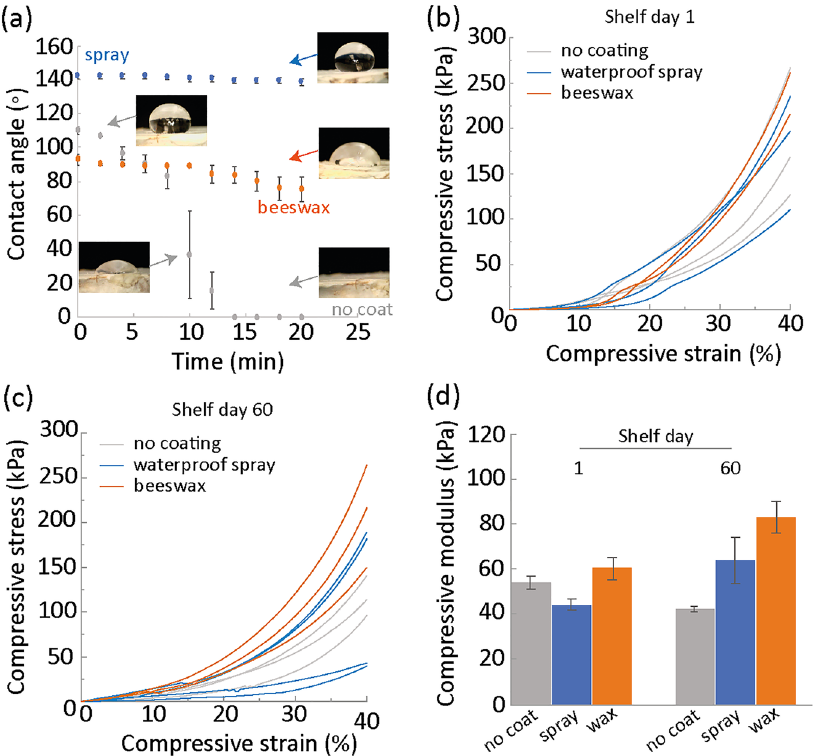
Figure 4. Indoors durability for MBC with no coating (grey), waterproof spray coating (blue) and beeswax coating (orange). ( a ) Contact angle as a function of time after a drop of water was deposited at the surface of the samples. The images show the morphology of the drop at several time points. ( b ) Stress–strain curves obtained under compression for the MBC grown for 28 days, dried, and coated or non-coated. ( c ) Stress–strain curves obtained under compression for the MBC after 60 days indoors shelf storage. ( d ) Elastic modulus of the samples after 1 and 60 days indoors for the different